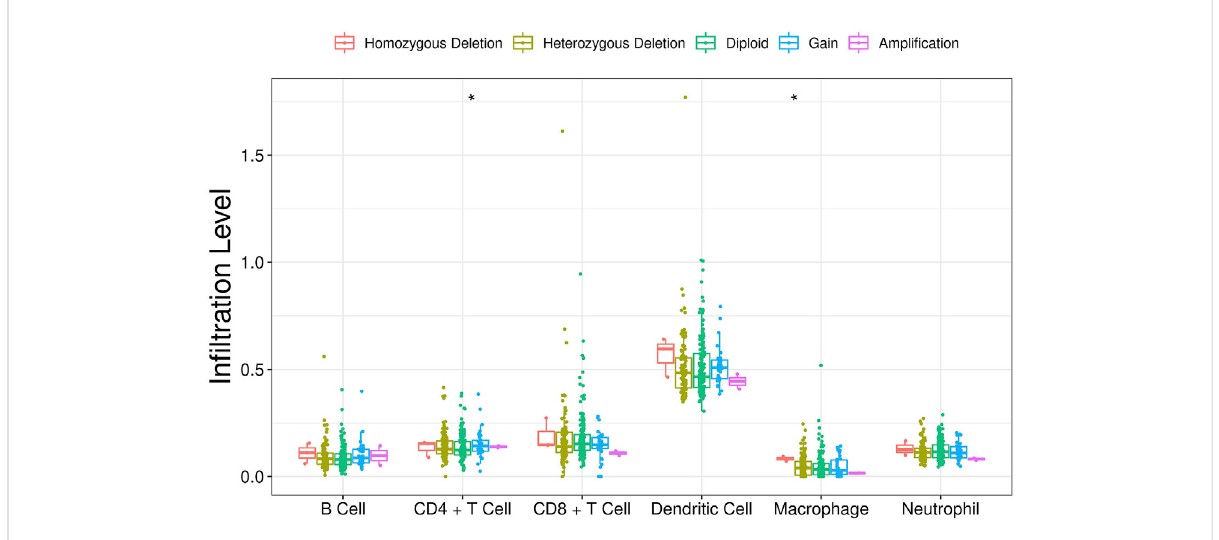
FIGURE 7 The in fi ltration level of six types of immune cells classi fi ed by the copy number variance (CNV) of the CMTM6